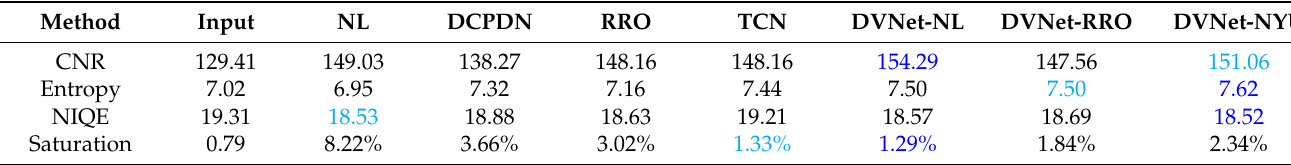
Table 5. Visual quality evaluation using CNR, Entropy, NIQE, and saturation, where blue and cyan colored numbers are the best and secondly best